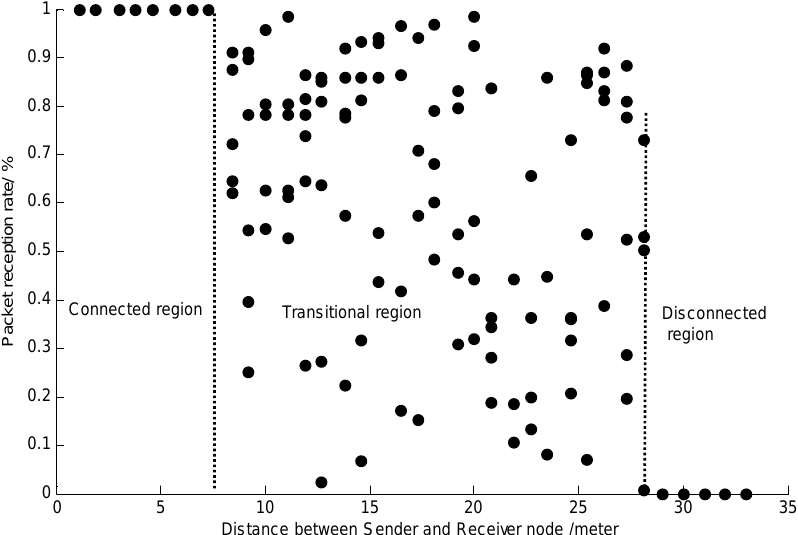
Figure 1. The spatial characteristic of the wireless